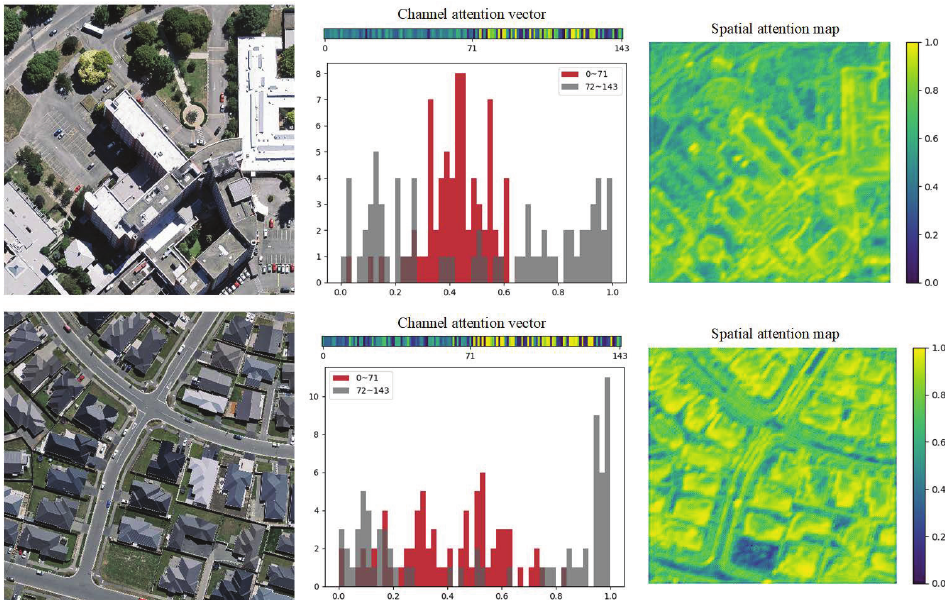
Figure 10. Visualization examples of the attention mechanism (best view in colors). The numbers 0–71 denote the feature map channels from the lower level, while 72–143 denote that from the higher level. The CBAM guides the network to pay different amounts of attention to different feature map channels and regions while addressing different